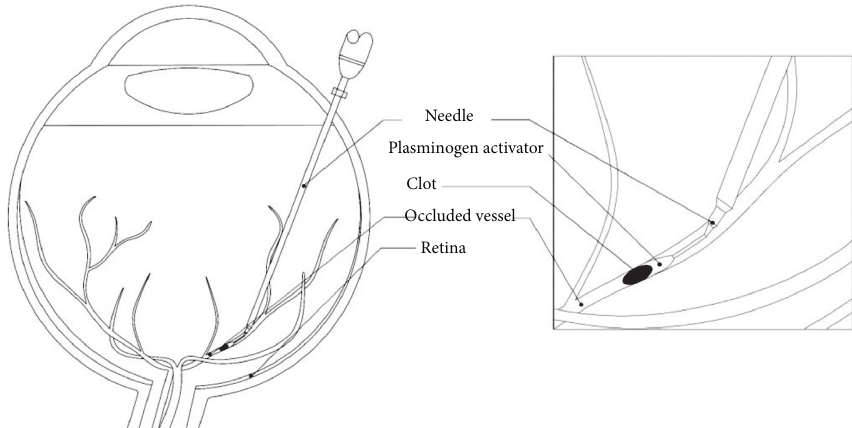
Figure 1: Retinal vessel cannulation to dissolve retinal vessel